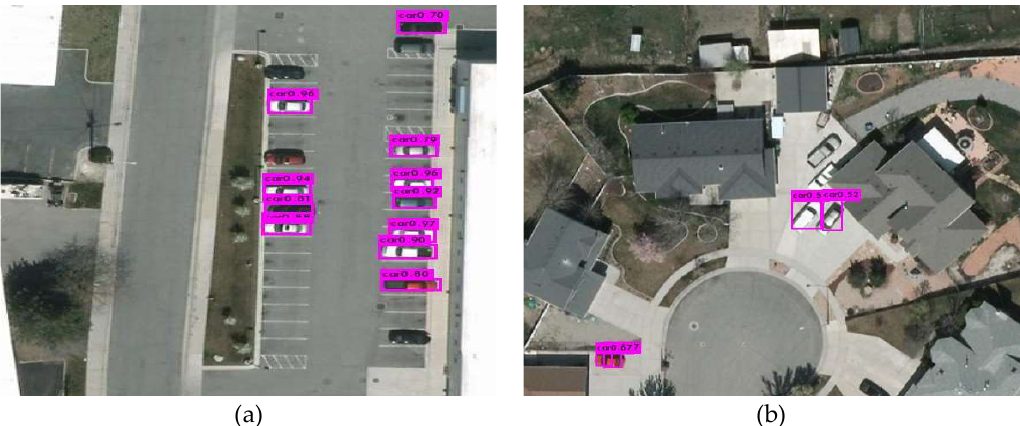
Figure 12. Detection examples for the VEDAI dataset: ( a ) Example 1; ( b ) Example 2.